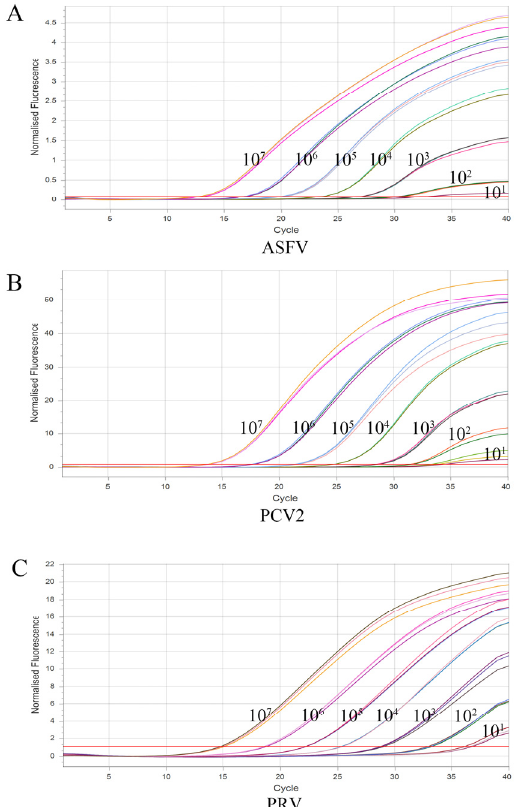
Figure 3. The amplification curves of the sensitivity test of the multiplex real-time qPCR. Multiple real-time qPCR sensitivity test using 10-fold serial dilutions of recombinant plasmids, with three repetitions of each dilution test. ( A ): ASFV sensitivity analysis; ( B ): PCV2 sensitivity analysis; ( C ): PRV sensitivity